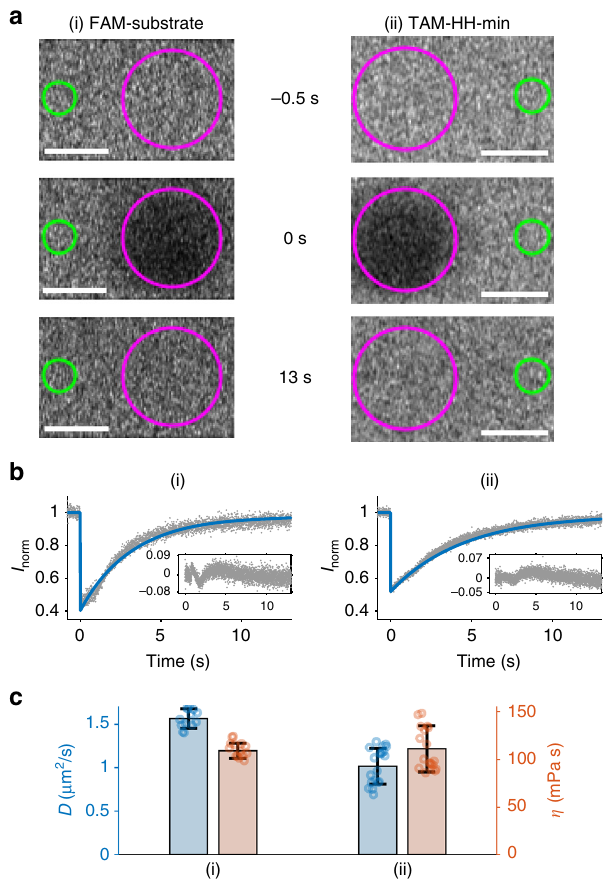
Fig. 2 FRAP of bulk coacervate phase. Bulk coacervate phase (CM-Dex:PLys (4:1 fi nal molar ratio) containing either (i) 0.36 μ M FAM-substrate or (ii) 0.36 μ M TAM-HH-min. a Output frames from confocal imaging (63×) are shown at t = − 0.5 s before bleaching, directly after bleaching (magenta circle, t = 0 s) and t = 13 s after bleaching. The fl uorescence intensity was normalised against a reference (green circle) and fi t to standard equations. Scale bars are 5 μ M. b Plots of normalised FRAP data for HH-min (ii) and FAM-substrate (ii) show the standard deviation (grey, N = 10) and fi t (blue) from the same bleach spot radius. c Diffusion coef fi cients and viscosities obtained from b . Mean and standard deviations are from at least two different samples with analysis from ≥ 14 bleach spots for